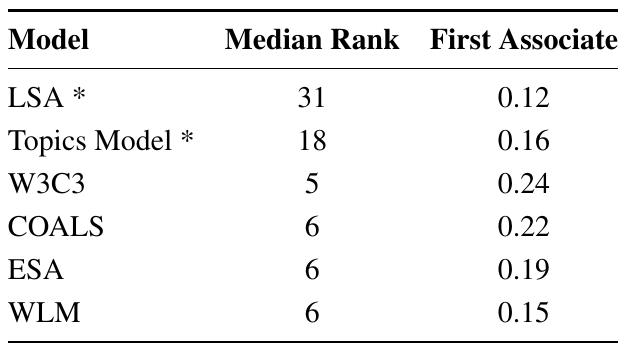
Table 10. Median rank of each model’s first five associates compared to human associates and proportion of model first associates that are the human first associate (N = 5,019).